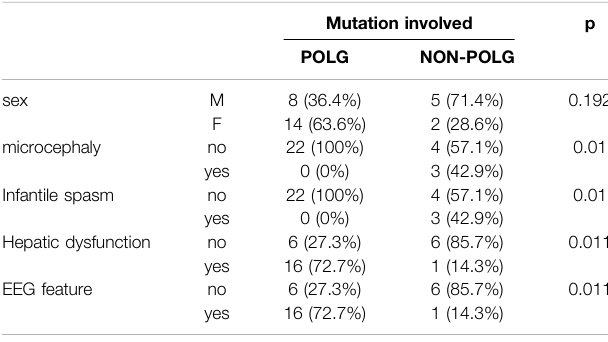
TABLE 3 | Comparison of mutations and clinical features of 29 cases with Alpers, syndrome by Fisher exact test. Mutation involved